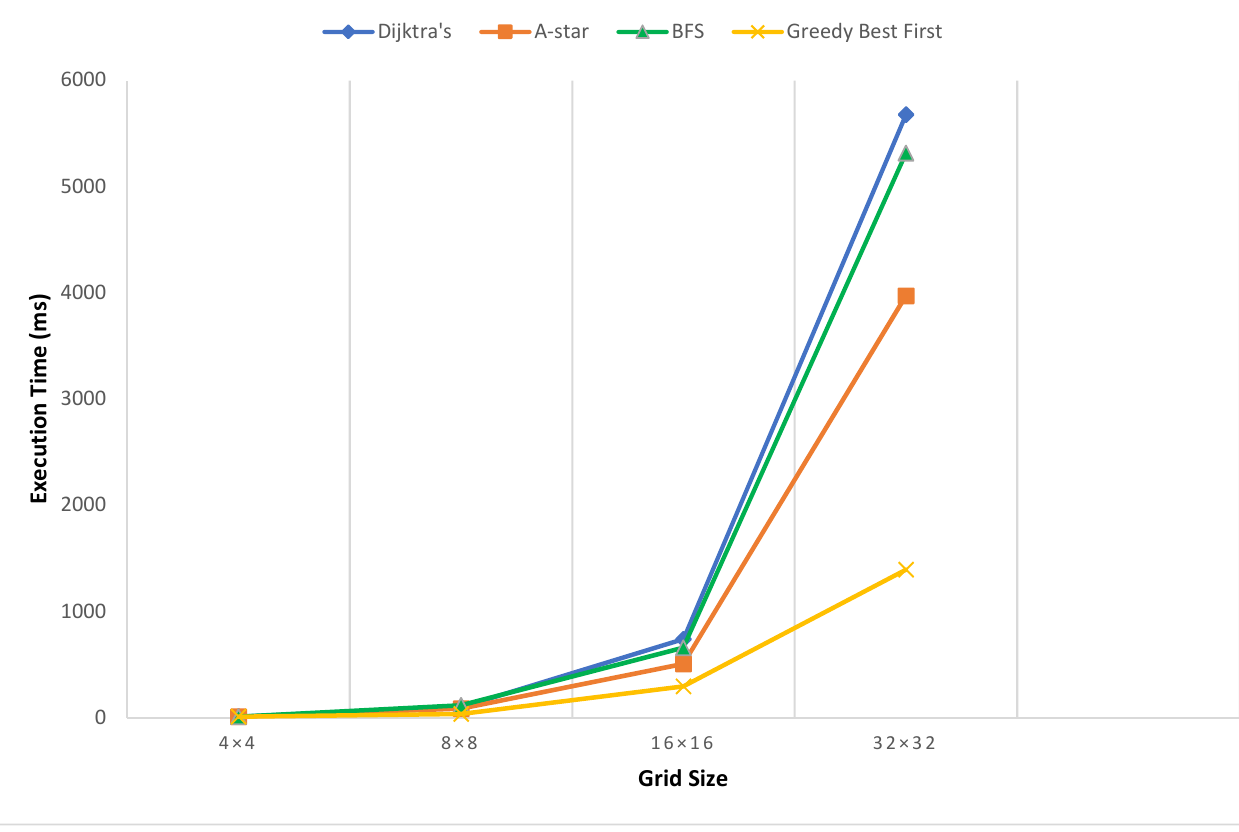
Figure 16. Graphical representation of pathfinding Algorithms with obstacles.